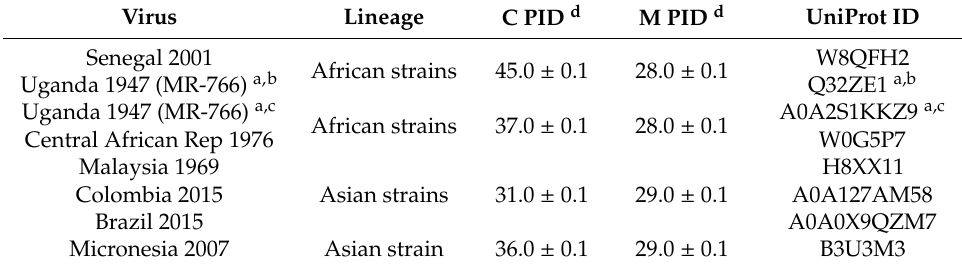
Table 1. Percentages of intrinsic disorder (PIDs) of M and C shell proteins from Zika virus (ZIKV) strains with UniProt accession. Di ff erences between the shell disorder in Asian and African strains are statistically significant (regression: r 2 = 0.9, F = 15, p < 0.01; one-way analysis of variance (ANOVA) with C percentage of intrinsic disorder (PID) as the sole independent variable: F = 11, p < 0.05). Higher PIDs in C proteins were found in the African strains even as the PID levels could di ff er for C proteins in strains from the same lineage. The regression was performed using the assumption that the African strains have greater fetal morbidity than do the Asian strains [38,39,55].